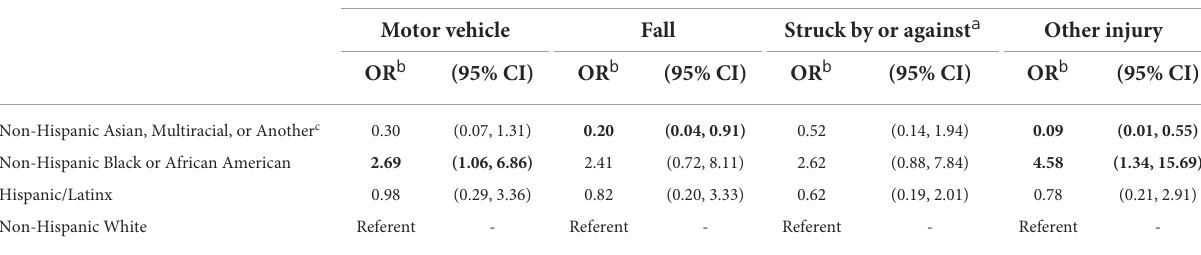
TABLE 4 Associations between race/ethnicity and injury mechanism for adult concussion emergency department